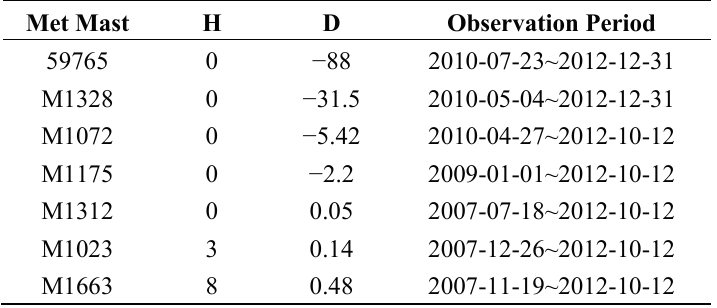
Table 3. In situ data from the seven masts are used in the comparison study. The altitude of met mast (H in m) and distance (D in km) to the nearest continental coast ( − ) or ocean (+) are given for all masts.